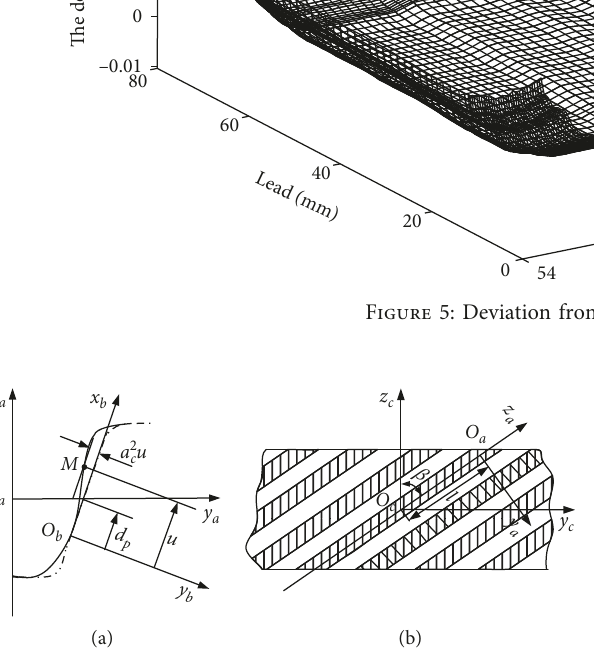
Figure 6: Coordinates of skew rack-cutter. (a) Parabolic profile of rack-cutter in normal section. (b) For derivation of rack-cutter surface.